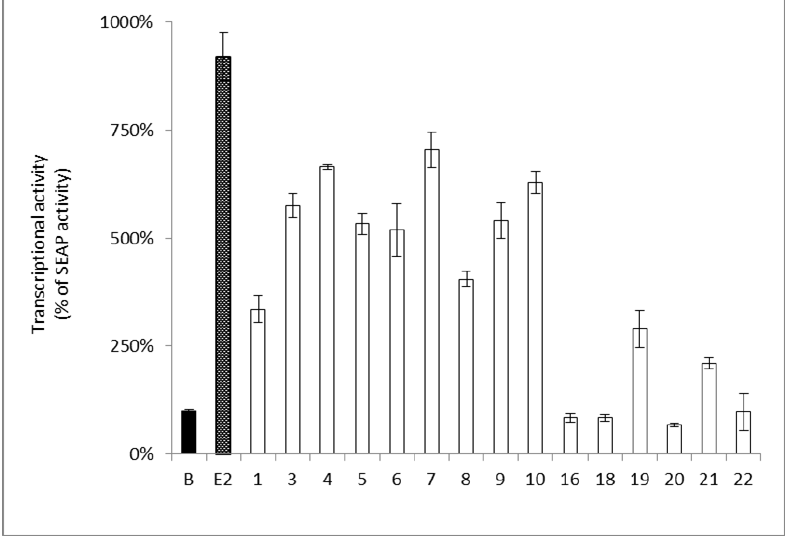
Figure 3. Estrogenic activity in MCF-7 cells of pure components from F. macrophylla. The SEAP activity induced by the positive control, E2 (0.1 nM). Cells were treated by the target compounds (10 μM) and the SEAP activity was compared to B (Blank), which was set to 100% SEAP activity. Each column represents a percentage of SEAP activity and is expressed as mean ± SEM ( n = 4).